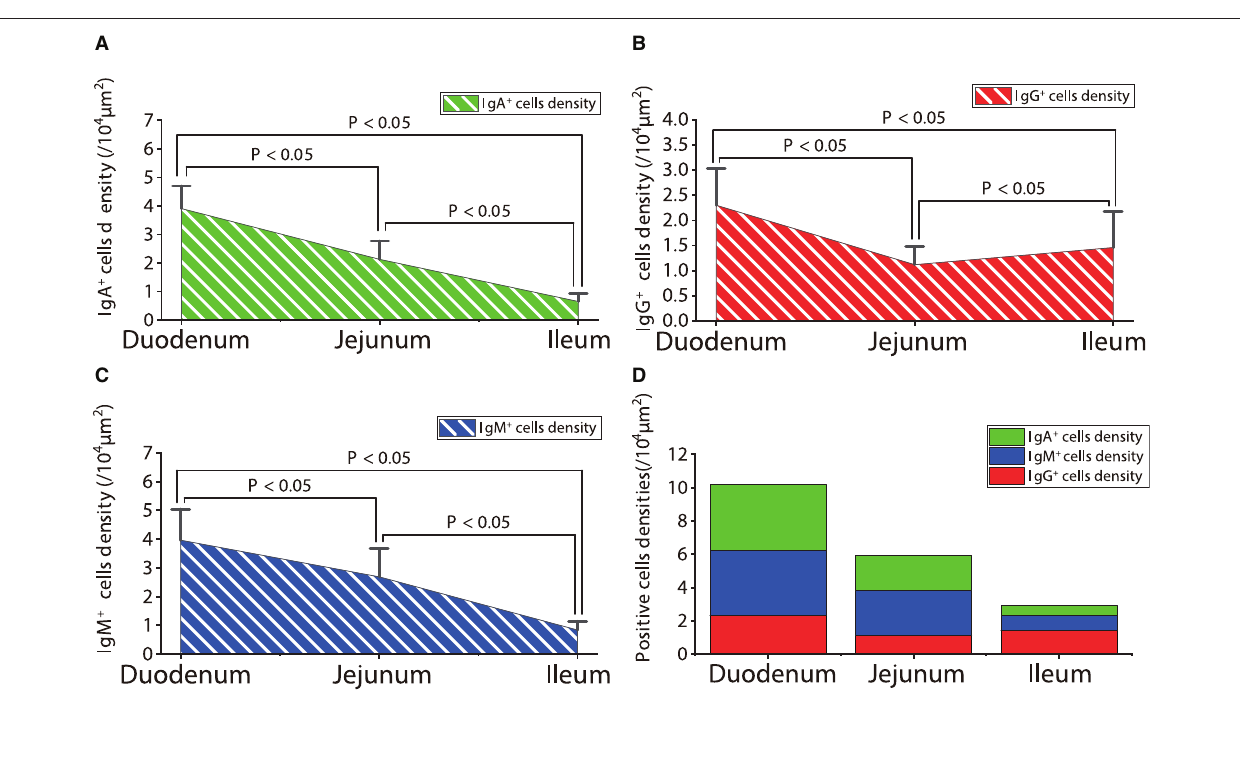
FIGURE 12 | The distribution densities of IgA + , IgG + , and IgM + cells in the small intestine of sheep after infection with Moniezia benedeni . (A) The distribution density of IgA + cells; (B) The distribution density of IgG + cells; (C) The distribution density of IgM + cells; (D) The total densities of IgA + , IgG + , and IgM + cells. P < 0.05 means significant